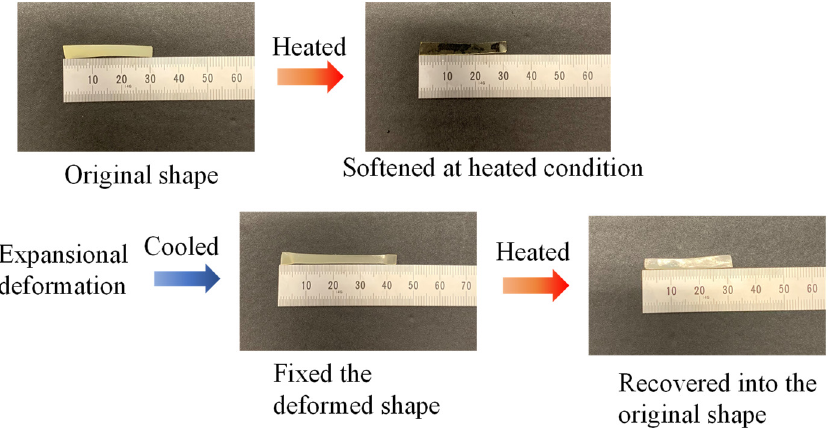
Figure 4. Shape memory of the crosslinked 2-poly(CL-co-BrBL)-MA. The memorized, expansional deformed shape recovered into the original shape by heating over the softening point.